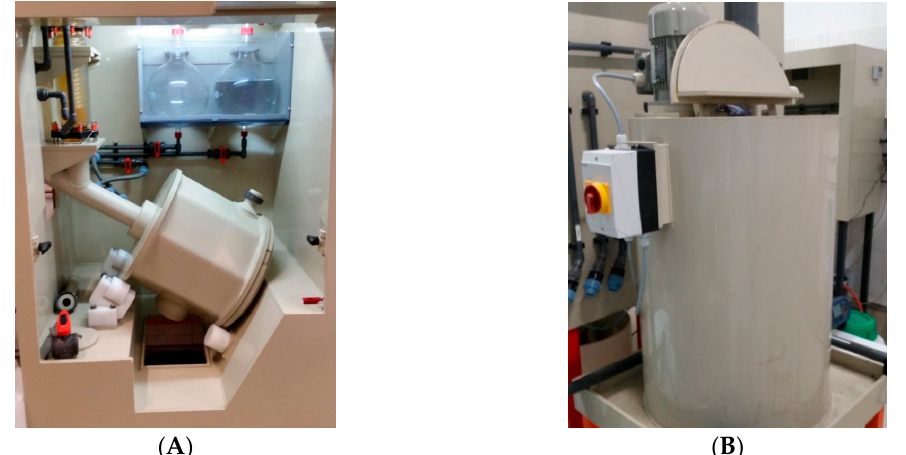
Figure 1. Leaching reactor ( A ) and tank for solution neutralization and cementation ( B ).